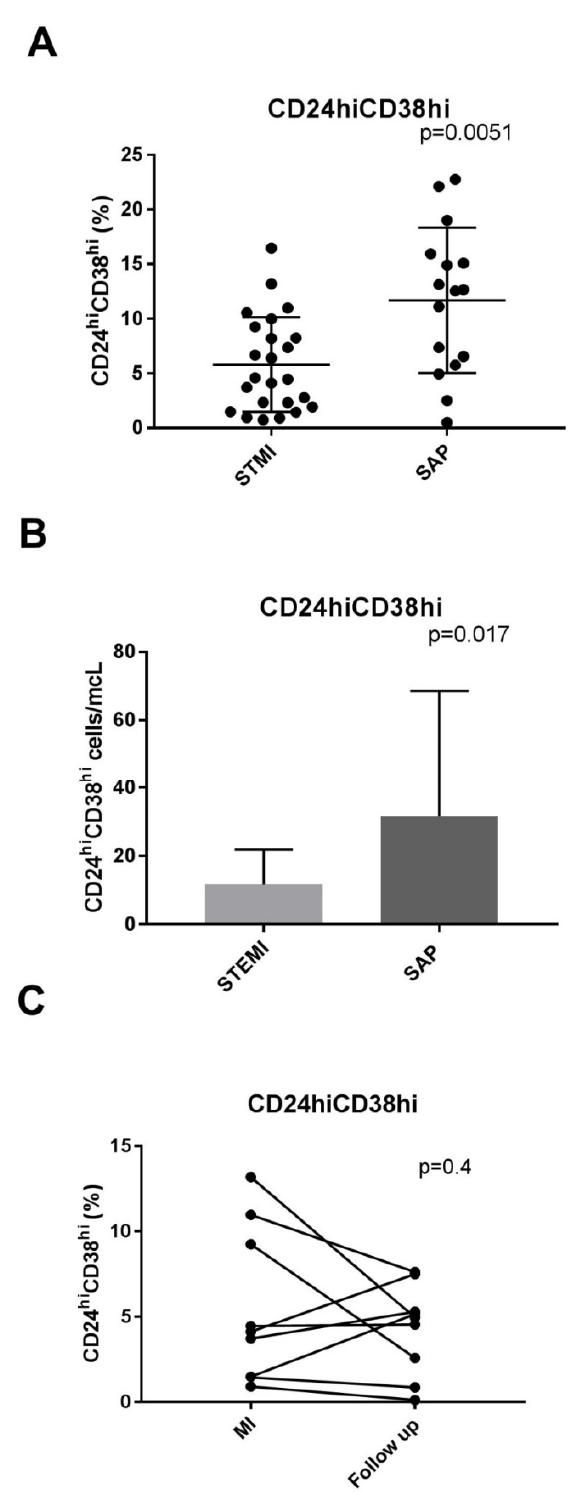
Figure 1. CD20+CD24 hi CD38 hi B cells from STEMI patients are lower compared to SA patients. ( A ) CD24 hi CD38 hi as a percent of CD20+ cells in STEMI patients and stable angina patients. Scatter plots show mean percentages of B-reg cells in the peripheral blood of STEMI and SA patients. ( B ) CD24 hi CD38 hi cells/mcL (absolute number) in STEMI patients and stable angina patients. ( C ) CD24 hi CD38 hi cells in patients with STEMI, acute phase compared to follow-up.